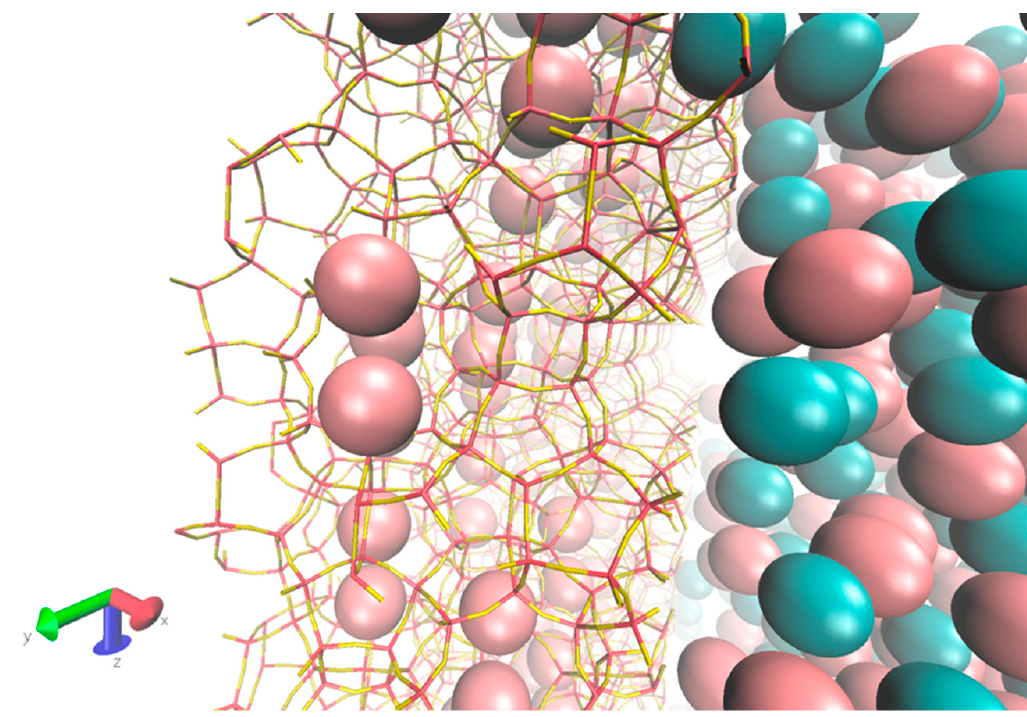
Figure 13. Close-up visualization of the gas-membrane interface at the beginning of the simulation, showing prefilled Xe atoms inside inner cages of DD3R in pink, while Kr is cyan.